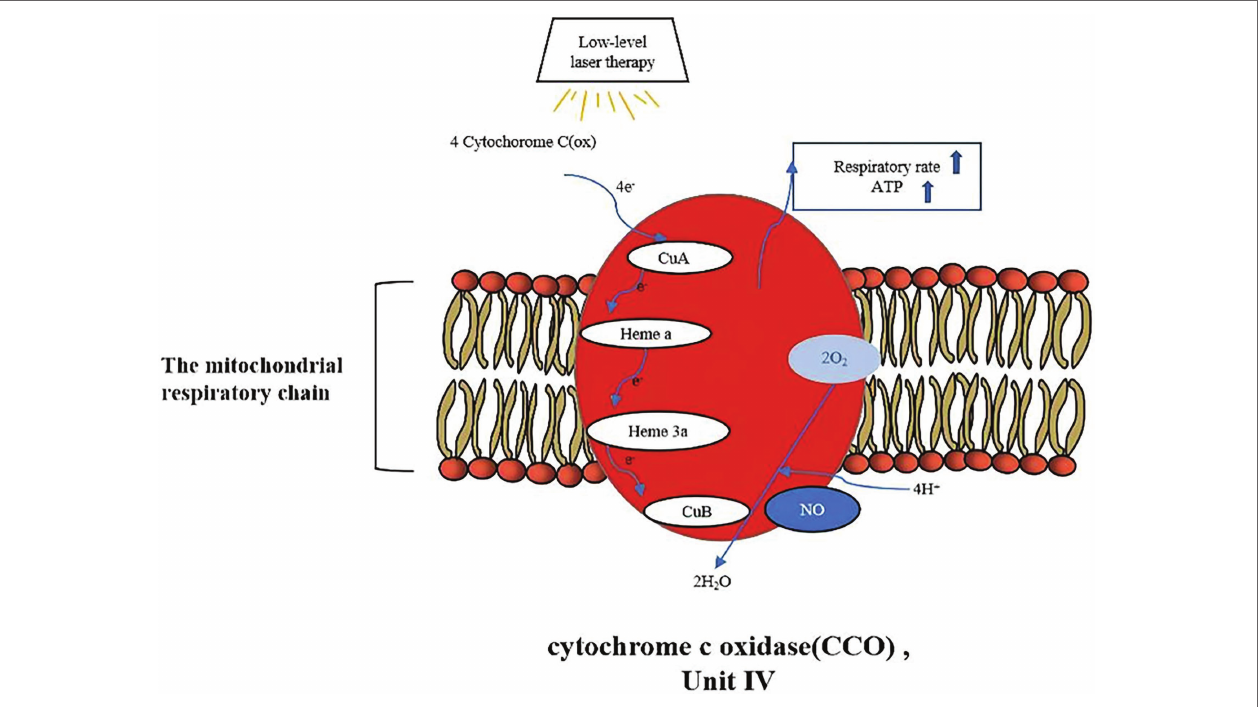
FIGURE 3 | The absorption of